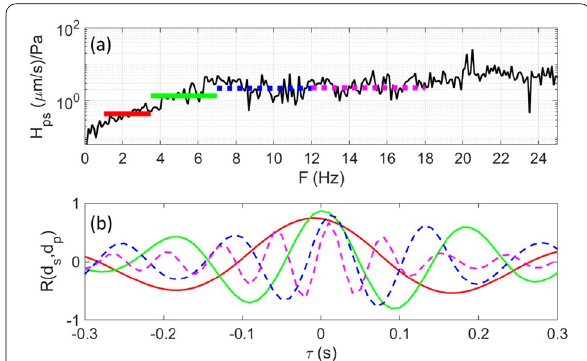
Fig. 3 a Amplitude response of the ground velocity to infrasound, H ps , obtained by this study is shown for 1–3.5 Hz (red line), 3.5–7 Hz (green line), 7–12 Hz (blue dashes), and 12–18 Hz (purple dashes). The results are compared with the response function obtained by Ichihara (2016) (black line; Fig. 1d). b Corresponding cross-correlation coefficient between the phase-shifted seismic data, d h v , and the infrasonic data, d p . The colors indicate the frequency bands as in a